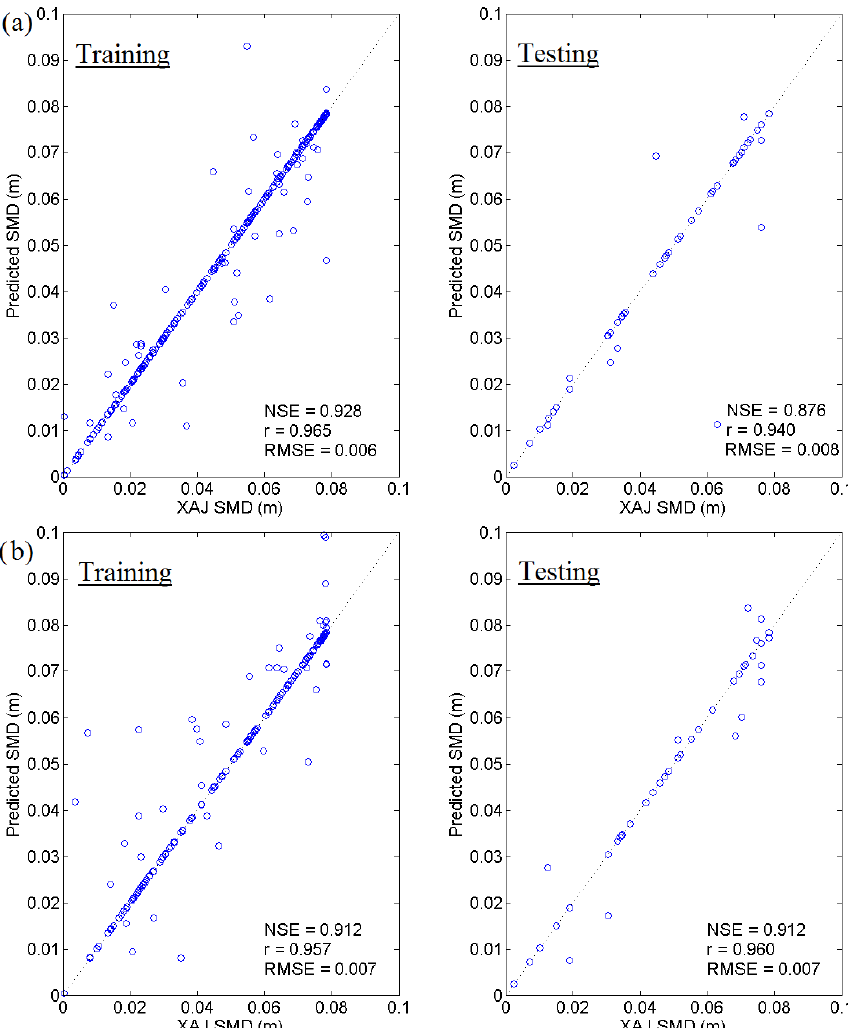
Figure 8. LLR modelling during the training and testing phases for (a) scheme 3 and (b) scheme